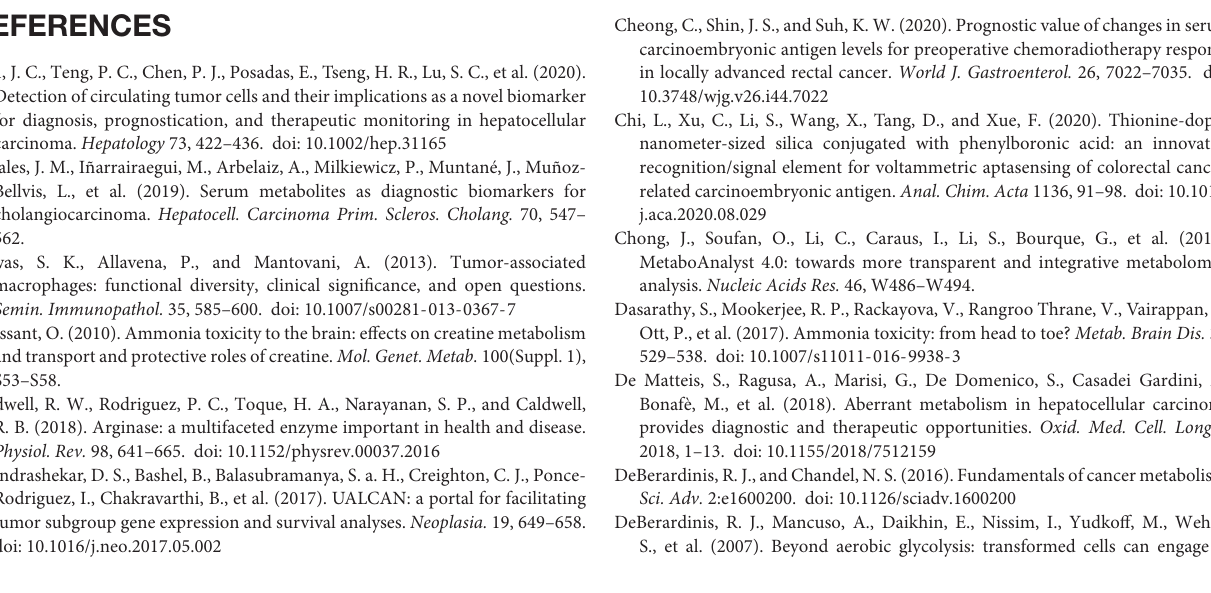
Supplementary Figure 1 | MetaboAnalyst analysis on altered metabolic pathways in HCC and HBV patients. (A) Results from MetaboAnalyst showing altered metabolic pathways in HCC patients versus healthy controls. Pathways are labeled: Arginine biosynthesis (1), Purine metabolism (2), Alanine, aspartate and glutamate metabolism (3), D-Glutamine and D-glutamate metabolism (4), Pyruvate metabolism (5), Citrate cycle (TCA cycle) (6), Cysteine and methionine metabolism